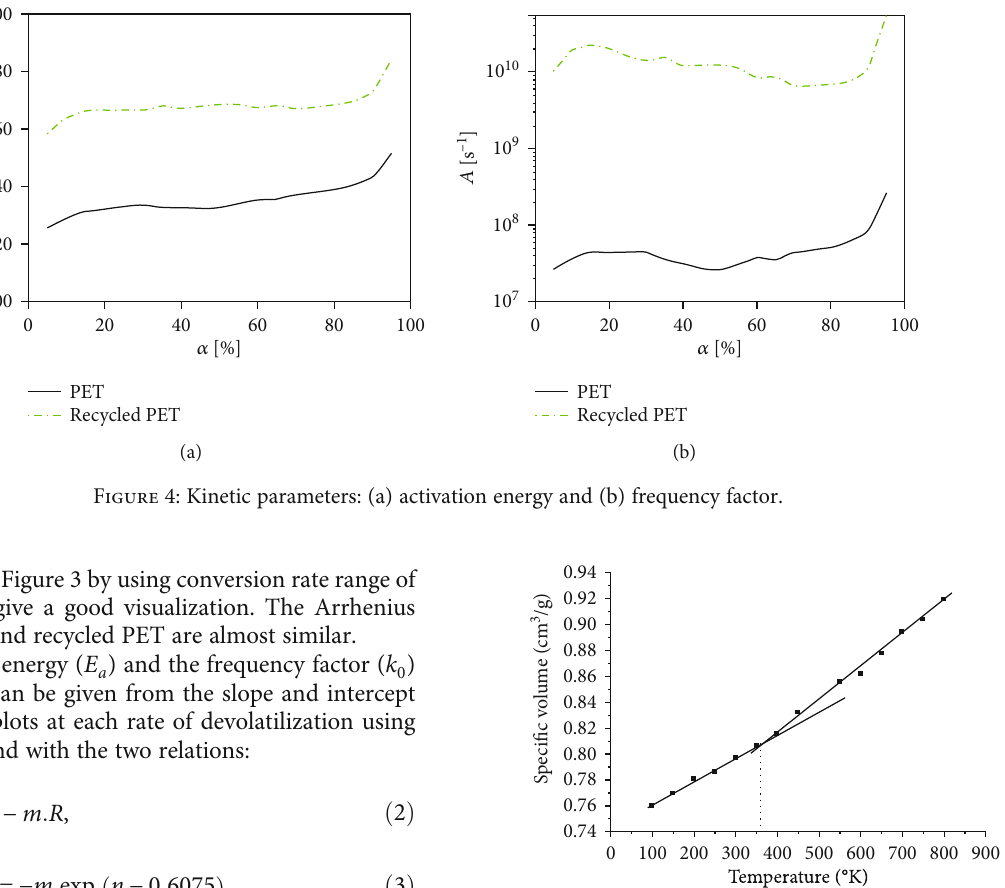
Figure 5: The speci fi c volume vs. temperature for